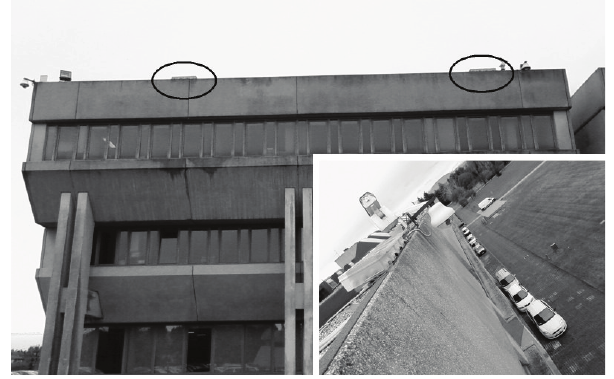
Figure 4: The prototype installed on the roof of the University building. The two arrays are encircled.